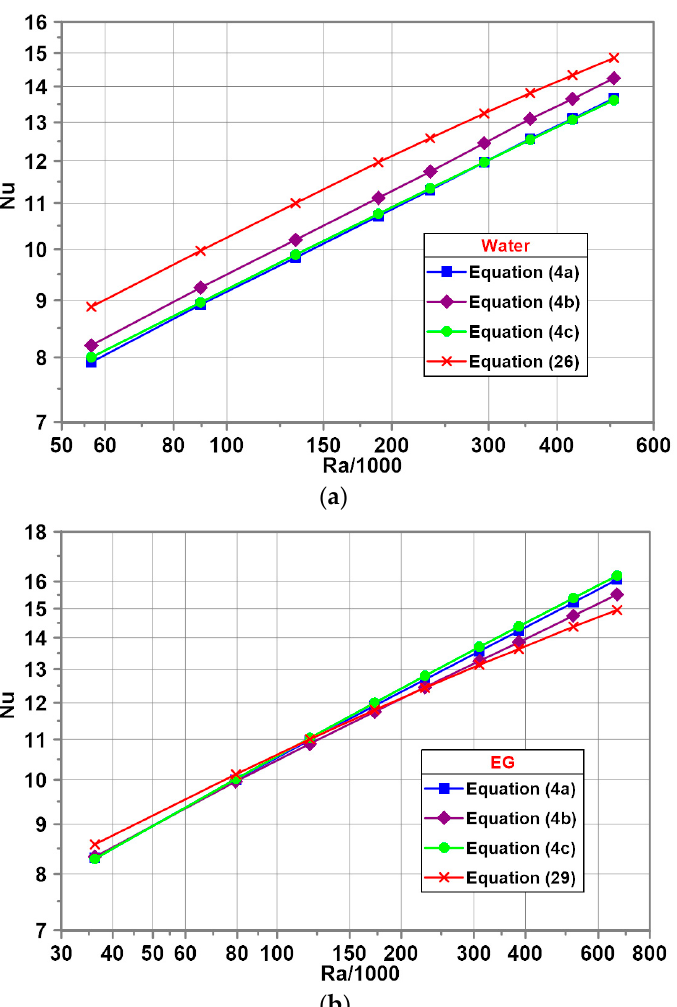
Figure 11. Impact of characteristic temperature determination on Nu-Ra relationship for water ( a ) and EG ( b ).